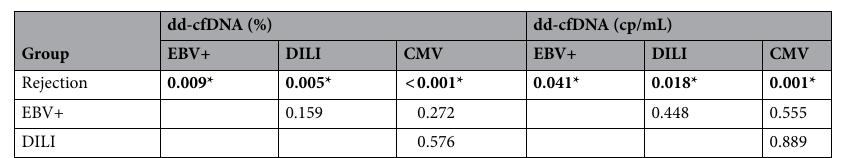
Table 2. Summary of statistical significances ( p -values) from different subgroup. Bold and “*” represent significant differences (p-values < 0.05). DILI drug-induced liver injury, EBV Epstein–Barr virus, CMV cytomegalovirus, dd-cfDNA donor-derived cell-free